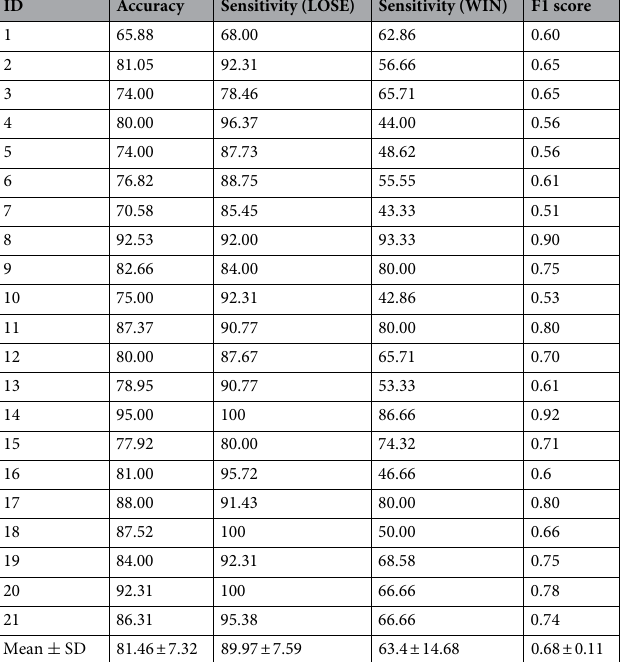
Table 4. The accuracy and sensitivity of distress (LOSE) and non-distress (WIN) classes, and F1 score values for each participant results for task